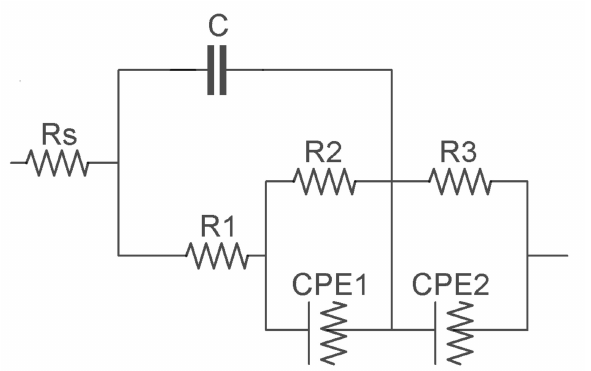
Figure 6. Equivalent circuit for fitting the